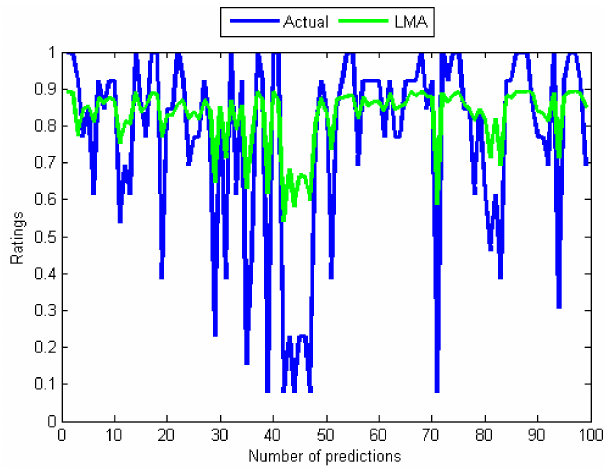
Figure 8. Curves of actual ratings and predicted ratings of LMA.